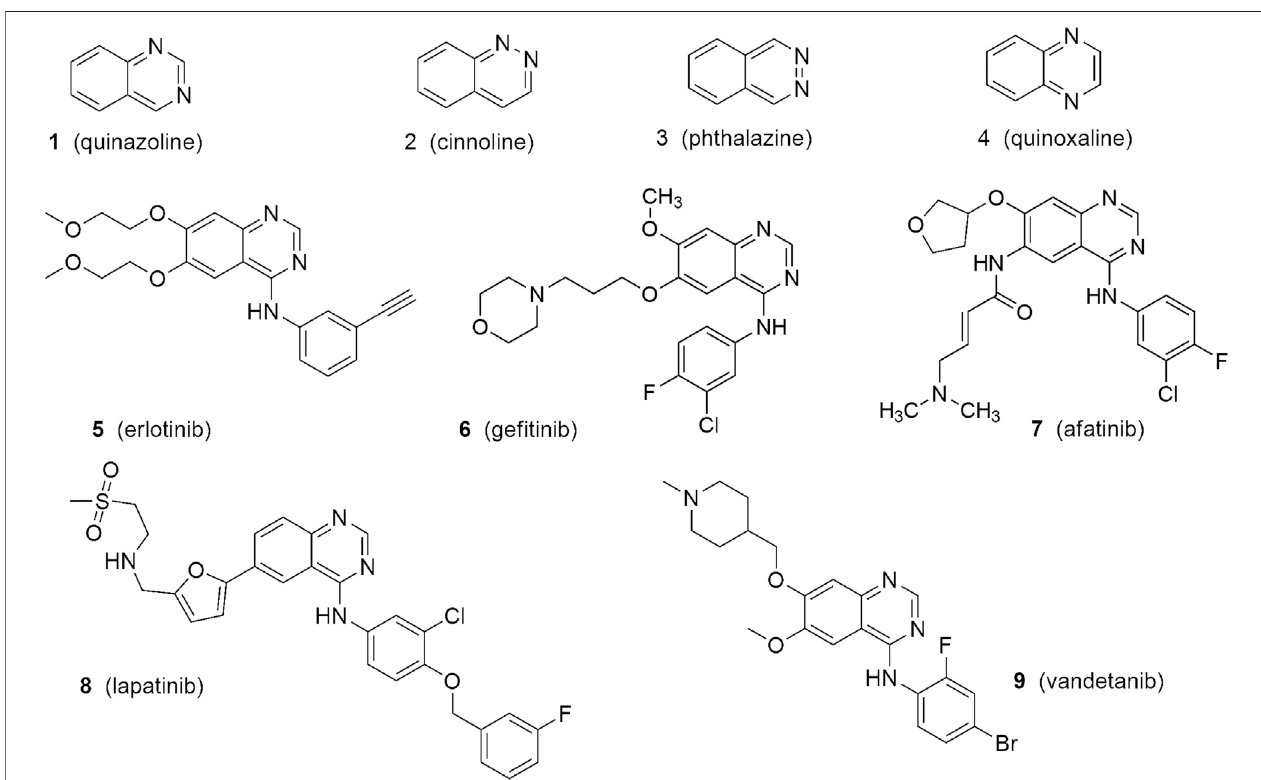
FIGURE 1 | Structures of quinazoline and quinazoline-based anticancer drugs.